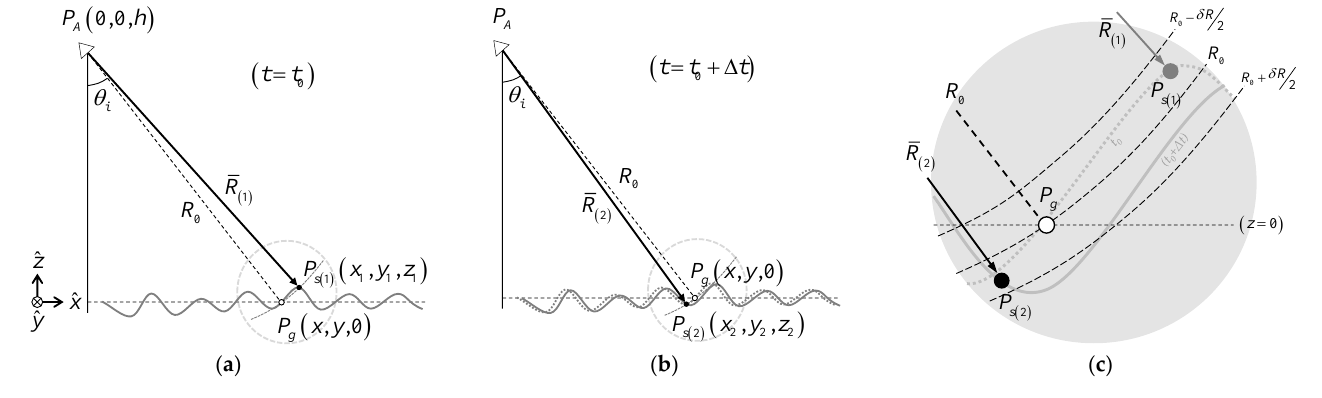
Figure 4. Radar geometries to establish the self-interferometric phase model: ( a ) an initial state at ( t = t 0 ), ( b ) the next state after Δ t , and ( c ) the ranges to target ( R (1) , R (2) ) compared with a reference range ( R 0 ) (where δR is a slant range resolution).